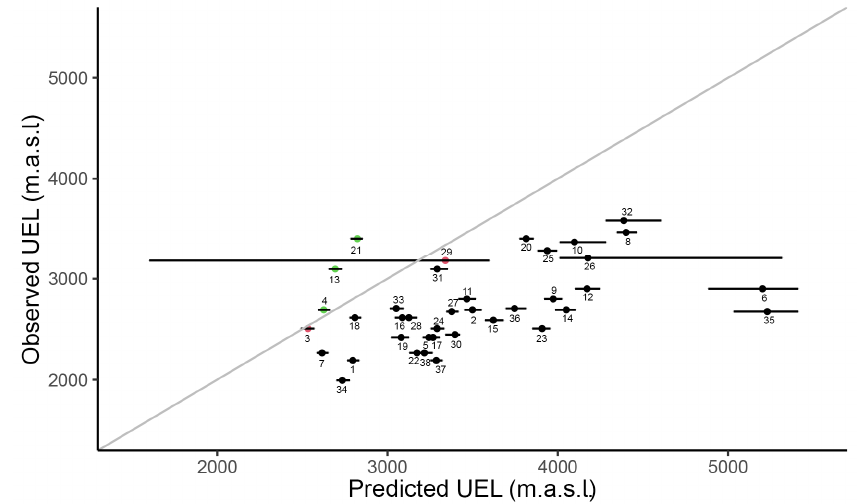
Figure 2. Comparison between observed upper elevation limits (UELs) along two mountain roads in Central Chile (33° S) and UELs predicted from the species’ global climatic niches. The grey line represents the x = y line (slope = 1). Points represent species (with ID) and horizontal black lines represent the 95% confidence intervals of the predicted UELs. Red points represent species in climatic equilibrium. Black points represent species that occur at a lower elevation than the predicted UEL. Green points represent species that occur at a higher elevation than the predicted UEL. 1: Anagallis arvensis ,